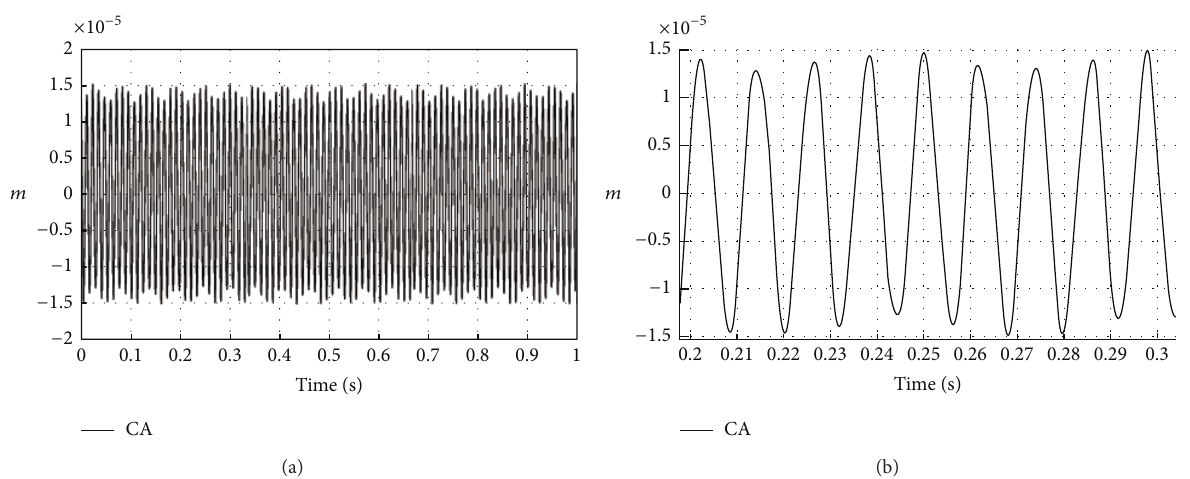
Figure 7: Response graph (a) of the simulation made by the CA, presenting the cell (𝑛/ 2 , 𝑛/ 2 ) on the 𝑧 -axis, (b) zoom-in of the simulation graphic.